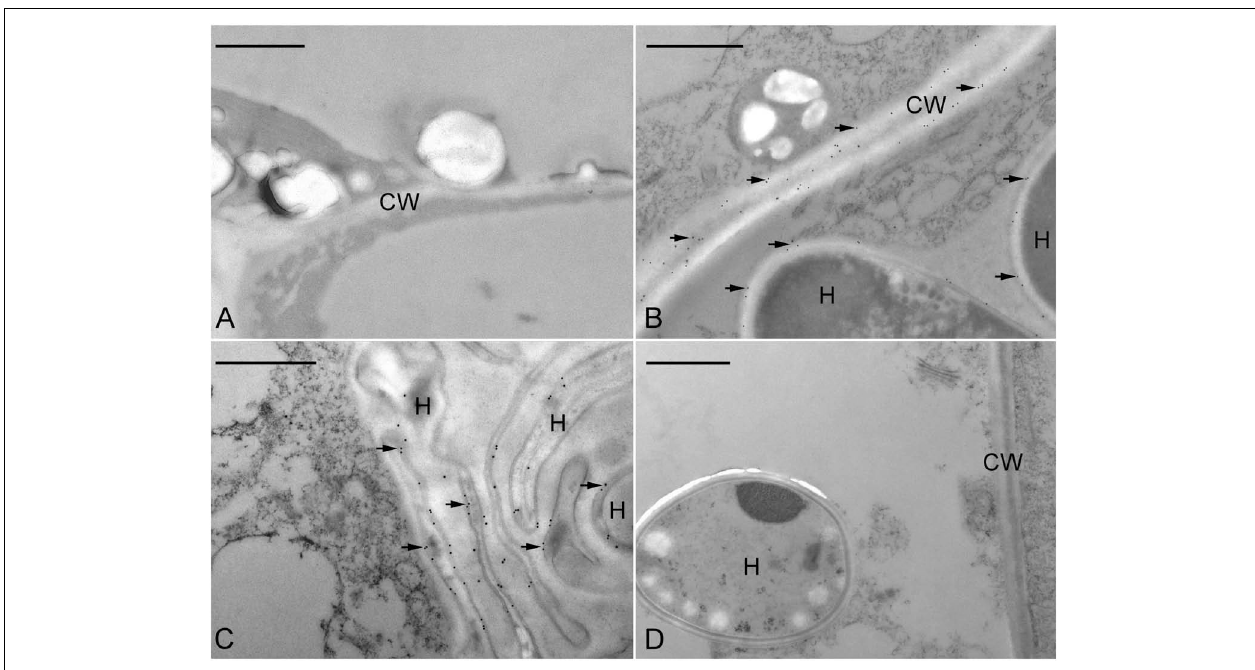
FIGURE 7 | Immunogold staining of JIM11 epitope in the symbiotic protocorms of D. officinale . (A) In the apical portion of the protocorm, no immunogold particles were observed. Scale bar = 1 µ m. (B) TEM of a basal portion of protocorm cell with fungal hyphae (H). Labeling occurred in the host cell wall (CW) and the interfacial matrix (arrowhead) or fungal cell wall. Scale bar = 1 µ m. (C) TEM of a portion of protocorm cell with collapsed fungal hyphae (H). Scale bar = 1 µ m. (D) The control staining. Thin sections were incubated with the mouse pre-immune IgG instead of JIM11 antibody. Immunogold particles were absent in these treatments. Scale bar = 1 µ m.